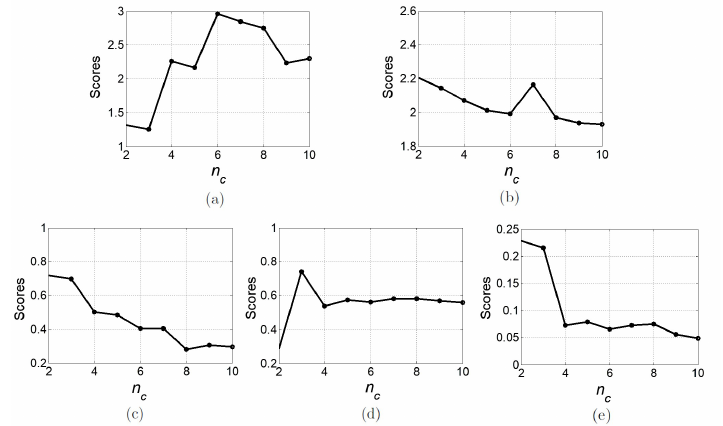
Figure 8. Evolution of CVIs for spring using HC for n c clusters indicated by: ( a ) XB ( ↓ ); ( b ) DB ( ↓ ); ( c ) DI ( ↑ ); ( d ) WI ( ↑ ); ( e ) Sil ( ↑